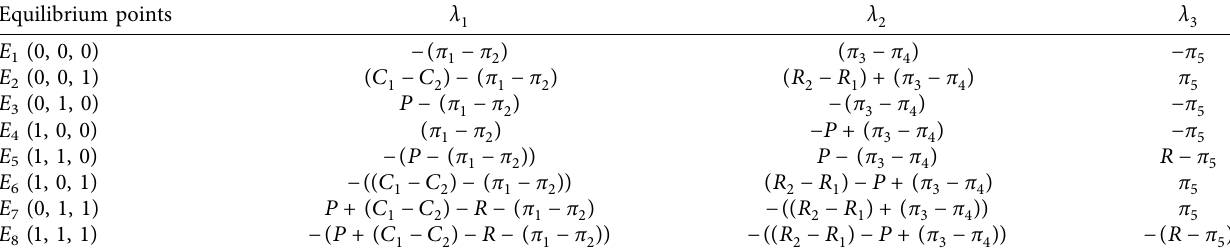
Table 2: Eigenvalues of the Jacobian matrix.